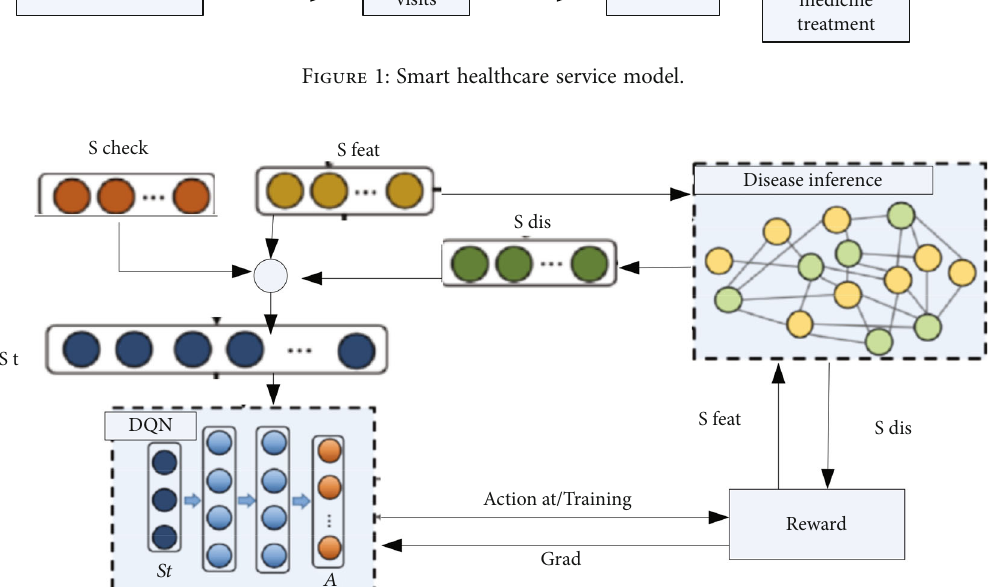
Figure 2: Active interactive intelligent diagnosis model framework